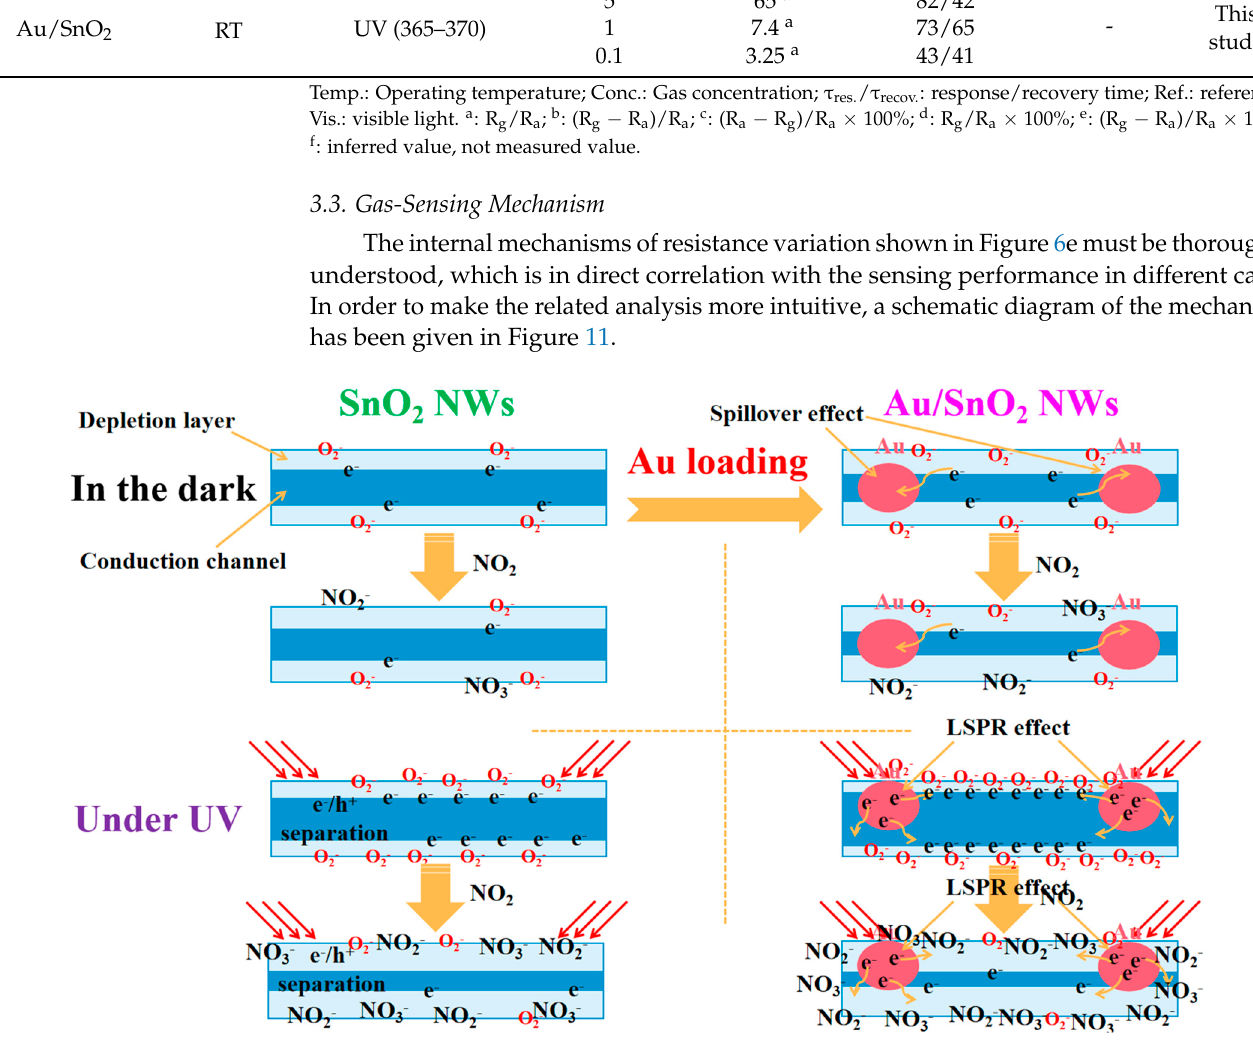
Figure 11. Schematic illustration of the sensing mechanism in this study. After Au loading, the initial resistance increased from 1.77 M Ω for pure SnO 2 to 68 M Ω for Au/SnO 2 at RT in the dark. In metal–semiconductor contact, a Schottky barrier will form at interfaces of Au and SnO 2 due to the difference in their work functions [64]. Specifically, the work functions of Au and SnO 2 were reported to be 5.1 [43,64] and 4.5~4.75 eV [33,46,48,53,54], respectively. Then, electrons will spontaneously flow from SnO 2 , with a lower work function, to Au, with a higher work function [33,43,46,64], result- ing in the generation of a depletion layer and an increase in resistance. When detecting oxidizing NO 2 through n-type materials, a higher R a is not considered disadvantageous despite the response equation being R g /R a and considering that a lower carrier concentra- tion tends to produce a greater proportion of variation under equal conditions. In general, chemical sensitization is regarded to play a vital role in improving sensing properties for Au-catalyzed systems. On the one hand, Au nanoparticles can facilitate the chemisorption and dissociation of both target gas and oxygen due to their high catalytic efficiencies [21,22,43]; on the other hand, all dissociated species will be rapidly transferred from the Au nanoparticles to the oxide surface due to the well-known spillover effect of Au [21–23,43]. In fact, the increase in O C content due to Au catalyzation has been proven in Table 1. As shown, Au, acting as a medium, can enhance the quantity and efficiency of reactions occurring at the surface of metal oxide, which reasonably explains the improved sensing performance in Figure 6b compared with that in Figure 6a. However, the in- creased amplitude of sensing performance in this study is very limited, which indicates the suppression of the effects of Au at low temperatures. Under UV irradiation (0.42 mW/cm 2 ), the resistance of pure SnO 2 is sharply reduced from 1.77 M Ω to 160 K Ω , which can be attributed to the role of photoexcitation. When the photon energy of the excitation source exceeds bandgaps of SMOs, the occurrence of elec-